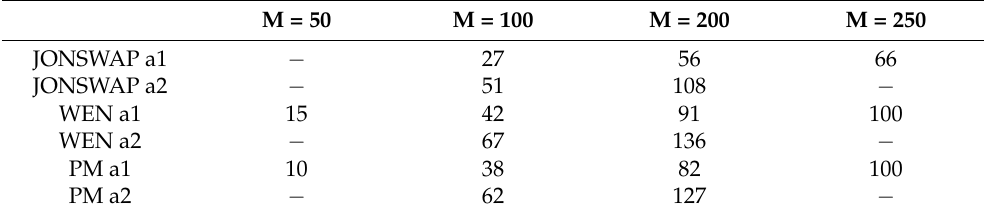
Table 1. The number of freak wave basic indicators a1 and a2 under different numbers of constituent waves (“−” represents that the number is too small and will not be recorded temporarily).